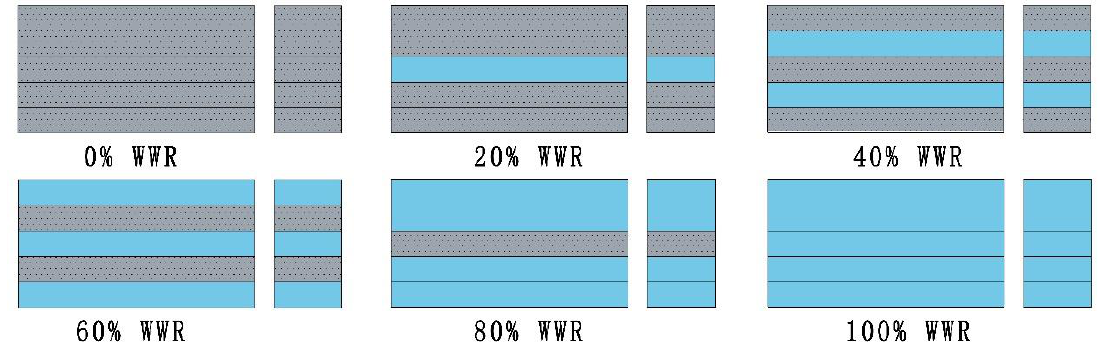
Figure 1. The typical residential unit in southern Hunan.